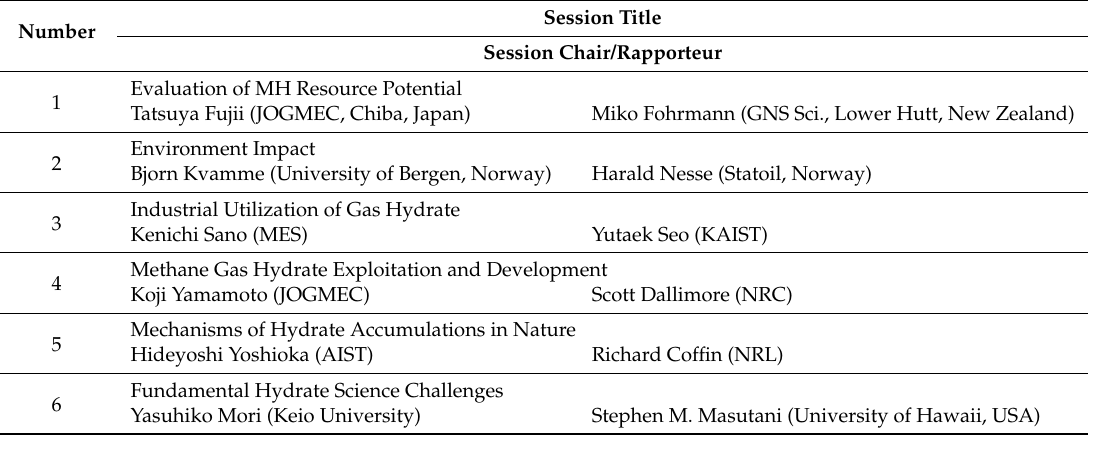
Table 9. Breakout sessions (title and chairs/rapporteur).